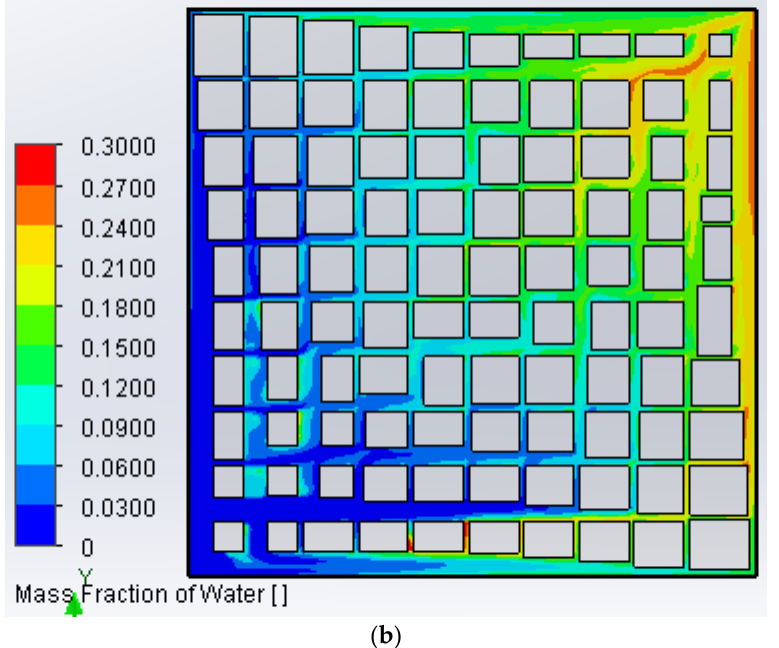
Figure 15. Mass fraction of water for both designs (upper limit set to 0.3) ( a ) unoptimized design; ( b ) MOGA design.